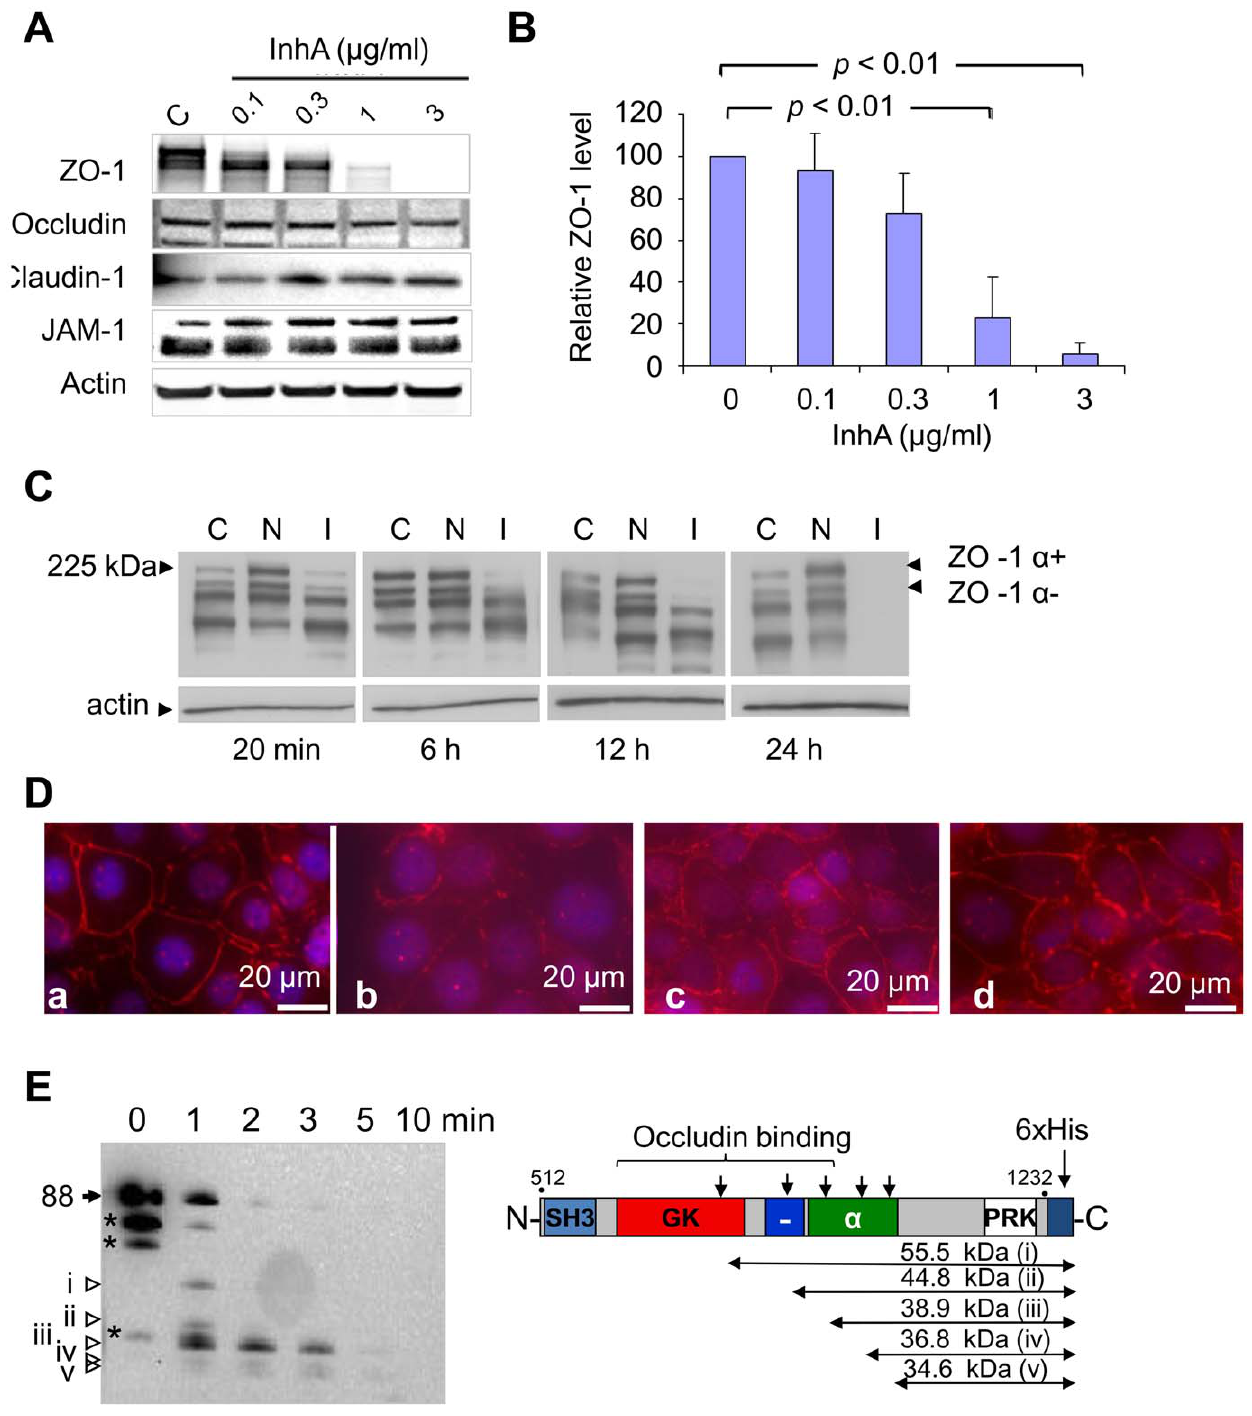
Figure 2. Western blot of TJ proteins in HBMECs after treatment with InhA. (A) HBMECs cells were treated with increasing concentrations of InhA (0.1, 0.3, 1, 3 m g/ml from left to right) for 24 h at 37 u C. Western blots were probed with antibodies to ZO-1 (225 kDa), occludin (56 kDa), claudin- 1 (22 KDa), and JAM-1 (39 kDa). (B) Densitometry of ZO-1 protein bands from (A). All samples analyzed ( n =4) were normalized to the intensity of corresponding b -actin bands. (C) Western blot analysis of time-dependent degradation of ZO-1 in HBMECs. Black arrows indicate two isoforms for ZO- 1. C , control; N , Npr599; and I , InhA; a + and a -, two splice variants of a domain. (D) Immunofluorescence of ZO-1 in HBMECs treated with or without 0.25 m g/ml of cytochalasin D for 1 h prior to incubation with varying concentrations of InhA at 37 u C for 12 h. Panels show HBMECs treated as follows: untreated (a); InhA-treated (b); cytochalasin D-treated (c); InhA-treated after cytochalasin D treatment (d). Scale bar: 20 m m. (E) Western blot of His 6 - tagged rZO-1. Degradation of purified rZO-1 after treatment with 0.1 m g/ml of InhA for indicated time at 37 u C. Putative cleavage sites within the rZO- 1fragment after treatment with InhA were deduced from immunoblot using the molecular masses of the cleavage products. SH3, Src homology 3; GK, guanylate kinase homolog; a , 80-amino-acid splice variant; -, acidic domain; PRK, proline-rich domain. b -Actin band intensity was used as a loading control for all Western blots. The results shown in (A)-(D) are representative of 4 independent experiments. doi:10.1371/journal.pone.0017921.g002 PLoS ONE | www.plosone.org